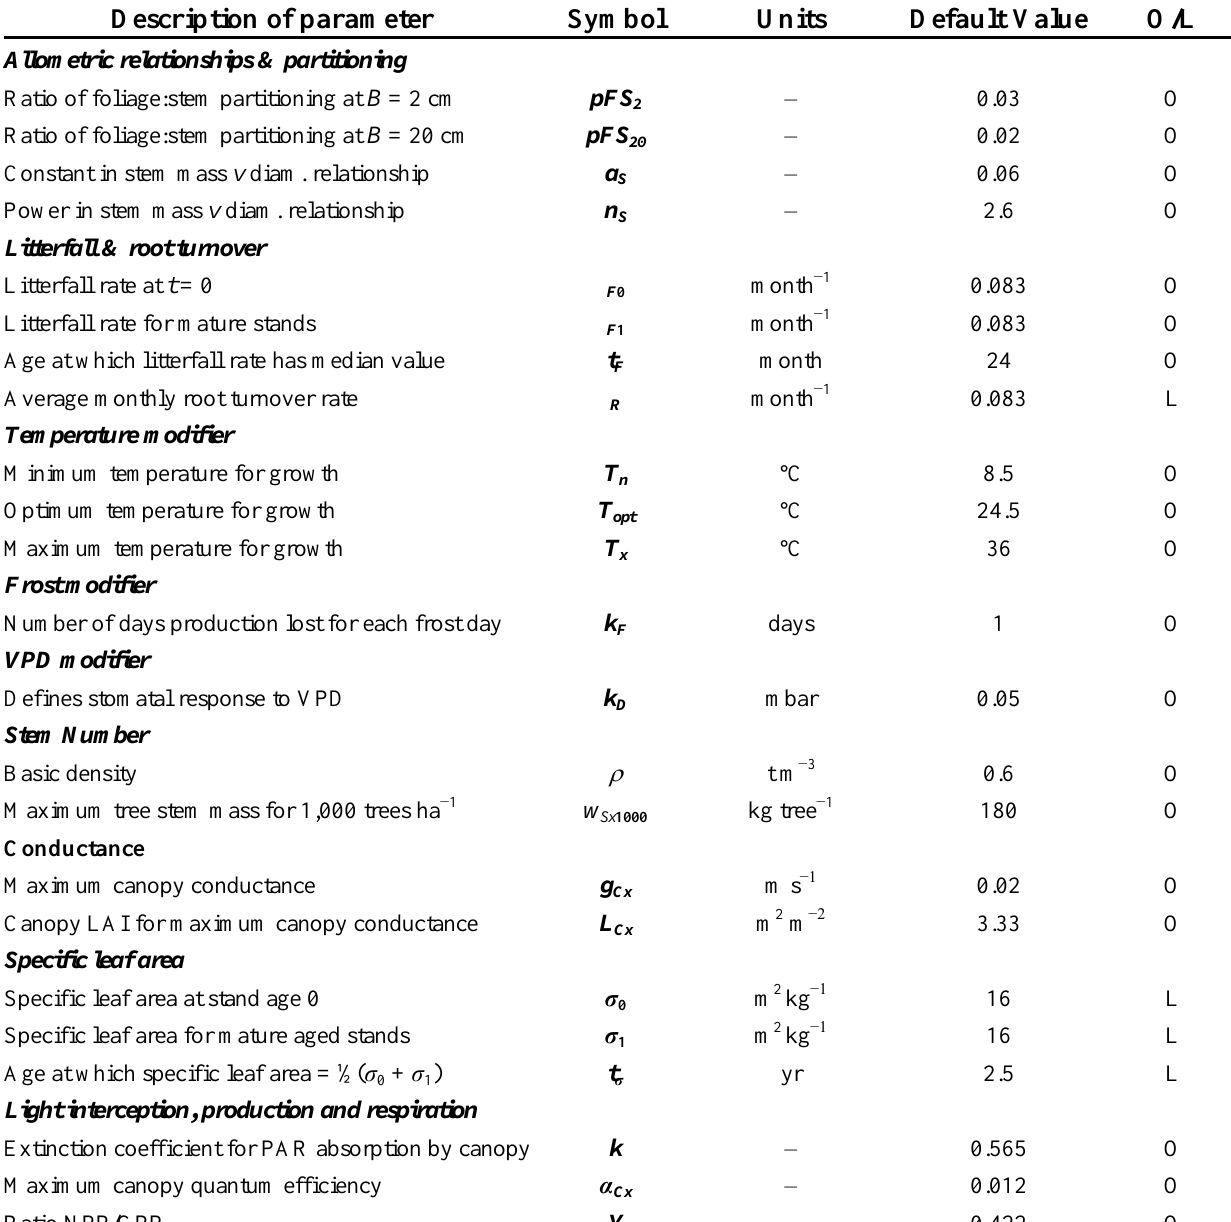
Table 3. List of parameter values as used in 3-PG for deciduous broadleaf forest. Most data are observed (O) from the experimental plot data and the others were obtained from the literature